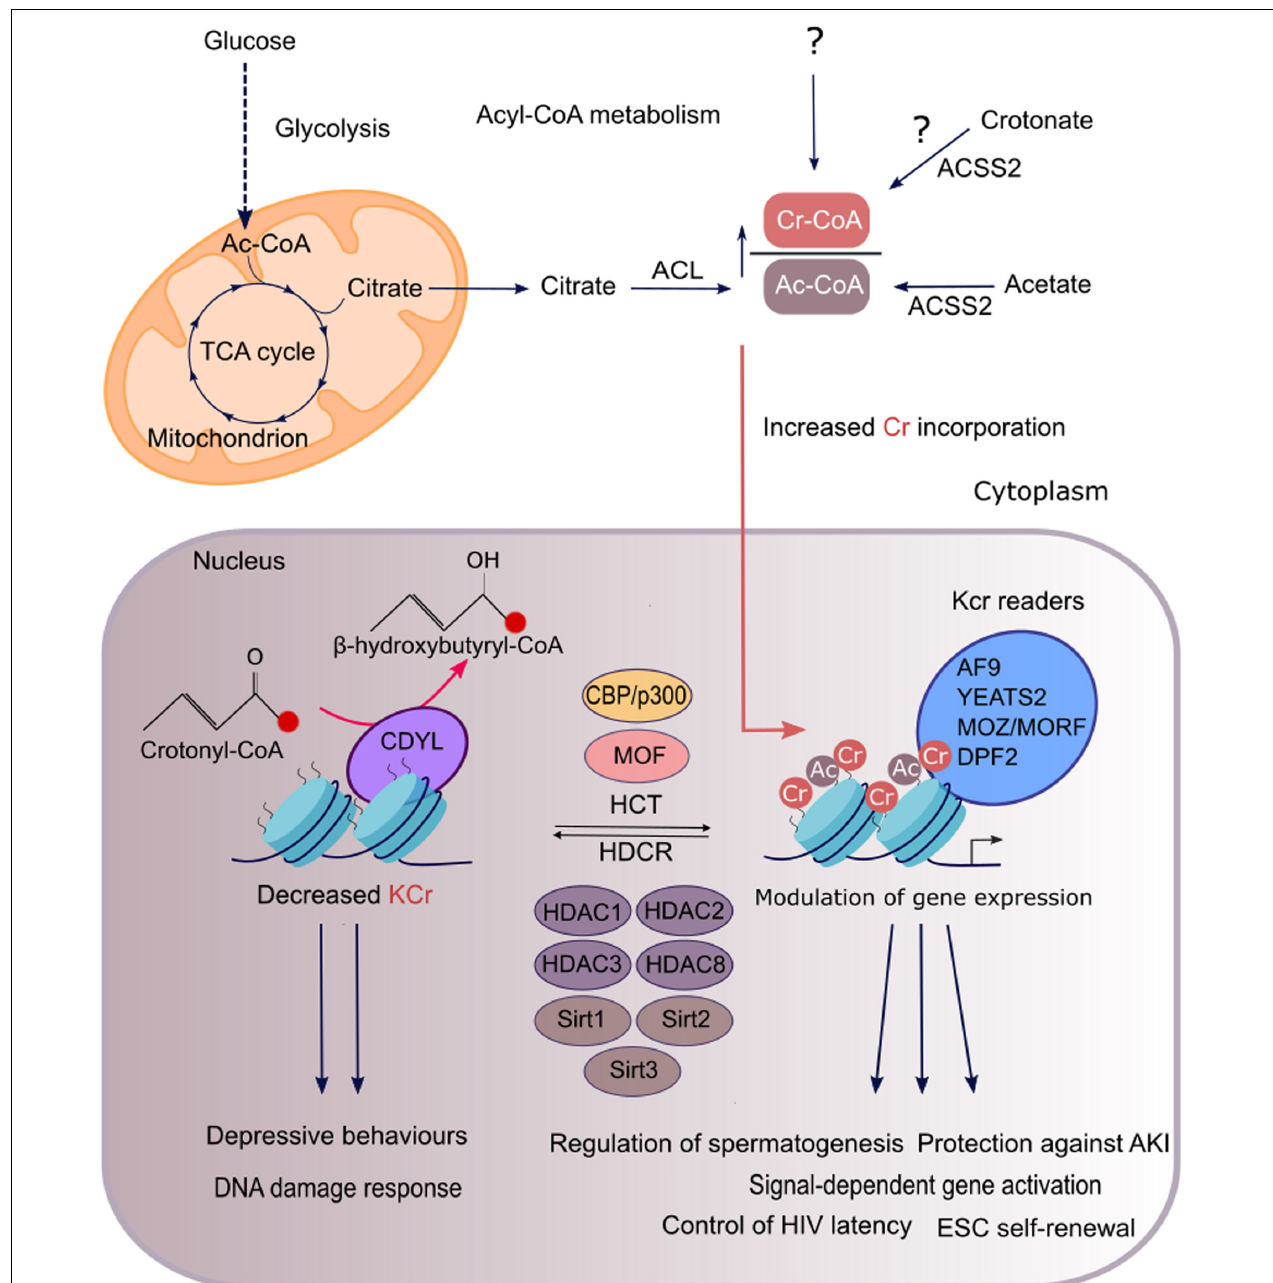
FIGURE 1 | Regulation and functions of histone crotonylation in mammalian cells. In genomic regions that are regulated by both histone crotonylation and acetylation, the degree of each modification is determined by the relative intracellular concentration of acetyl-CoA and crotonyl-CoA, which are produced through cellular metabolic pathways shown here. Acetyl-CoA is mainly synthesised from mitochondrial citrate, derived from glucose oxidation, by the enzyme ACL. Short-chain fatty acids, acetate and crotonate, can be converted to their cognate acyl-CoAs, that is mediated by ACSS2 at least for acetyl-CoA. Crotonyl-CoA is also generated as a by-product of fatty acid and amino acid metabolism. However, it remains unknown whether crotonyl-CoA generated through these pathways or an alternate route supplies the nuclear pool of crotonyl-CoA, which acts as a substrate for histone crotonylation (as indicated by the question mark). ACL and ACSS2 reactions can take place in both the cytoplasm and the nucleus. For simplicity only the cytosolic reactions are depicted. A high ratio of crotonyl-CoA to acetyl-CoA will favour the incorporation of crotonyl moieties into the chromatin by acyltransferases. The HATs p300/CBP and MOF have been characterised as crotonyltransferases (HCTs) while class I HDACs are the major HDCRs in mammalian cells. Some sirtuins (SIRT1,2,3) also exhibit HDCR activity. In addition, the chromodomain protein CDYL is a negative regulator of histone crotonylation, as it converts crotonyl-CoA to β -hydroxybutyryl-CoA, thus limiting the substrate available for histone crotonylation. Histone Kcr is selectively recognised by reader proteins which include YEATS2, AF9, MOZ, MORF, and DPF2 that can subsequently translate it into diverse functional outcomes. Histone crotonylation exerts diverse functions such as in gene activation, spermatogenesis, kidney injury, depression, DNA damage response, HIV latency, and maintenance of stem-cell